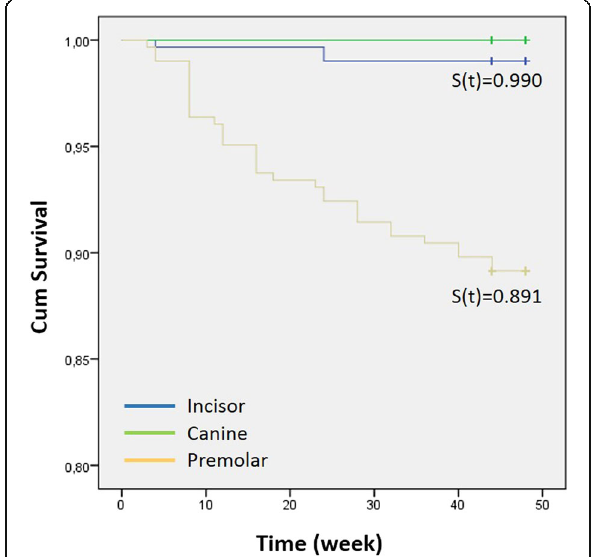
Fig. 3 Bracket survival distribution for tooth type (incisor, canine, and premolar)